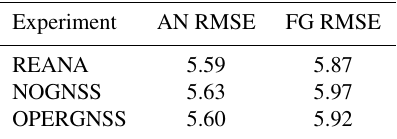
Table 4. Analysis (AN) and first-guess (FG) root mean square er- ror (RMSE) values for the wind (in ms − 1 ) computed with respect to RASTA observations (sample size of 33083 observations) for REANA, NOGNSS and OPERGNSS